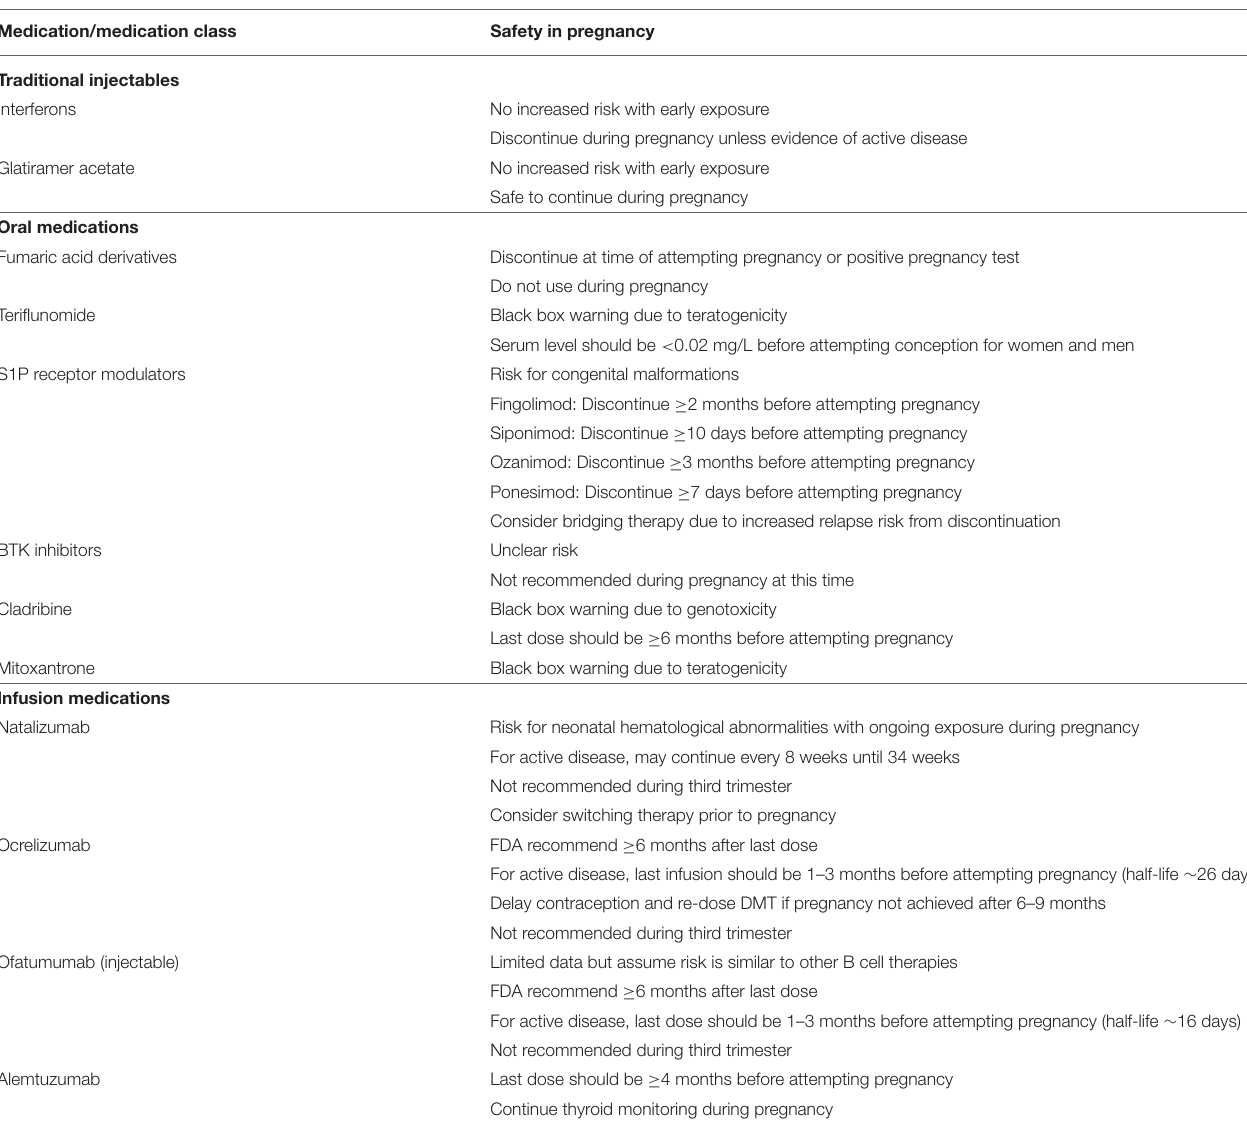
TABLE 2 | Recommendations on DMT use during pregnancy